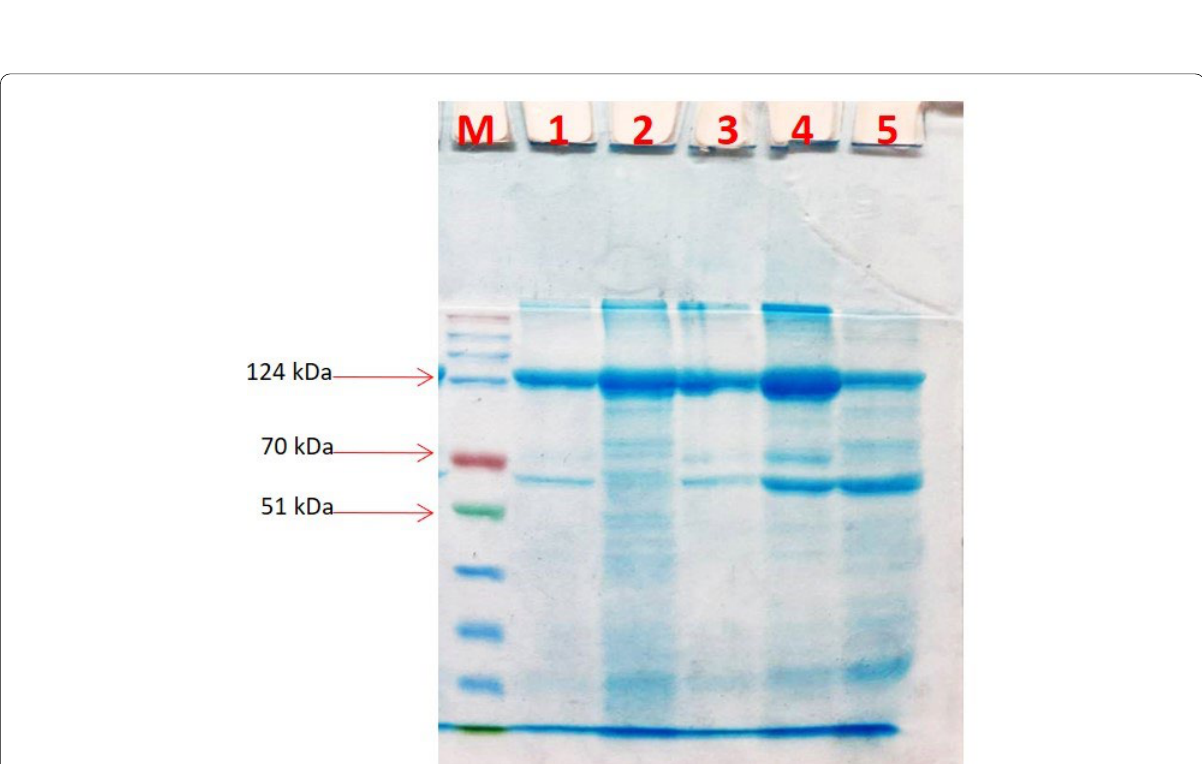
Fig. 2 Protein profile of Bacillus thuringiensis isolates. Lane M—Protein marker, Lane 1—HD-1, Lane 2—T28, Lane 3—T30, Lane 4—T357, Lane 5—